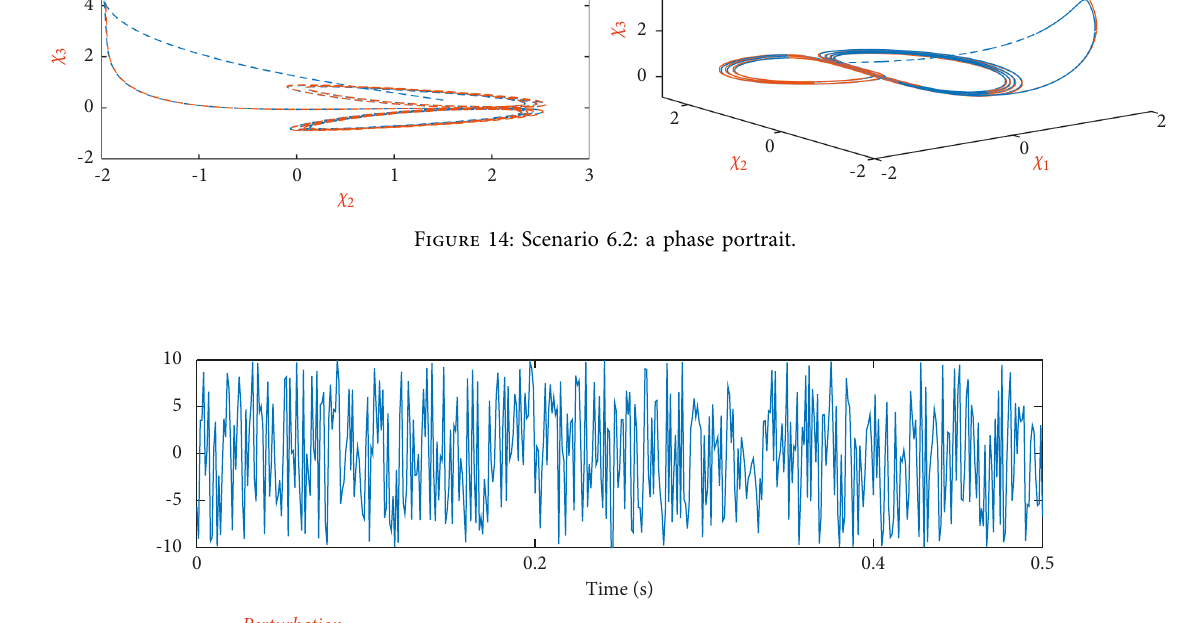
Figure 15: Scenario 6.3: random dynamic